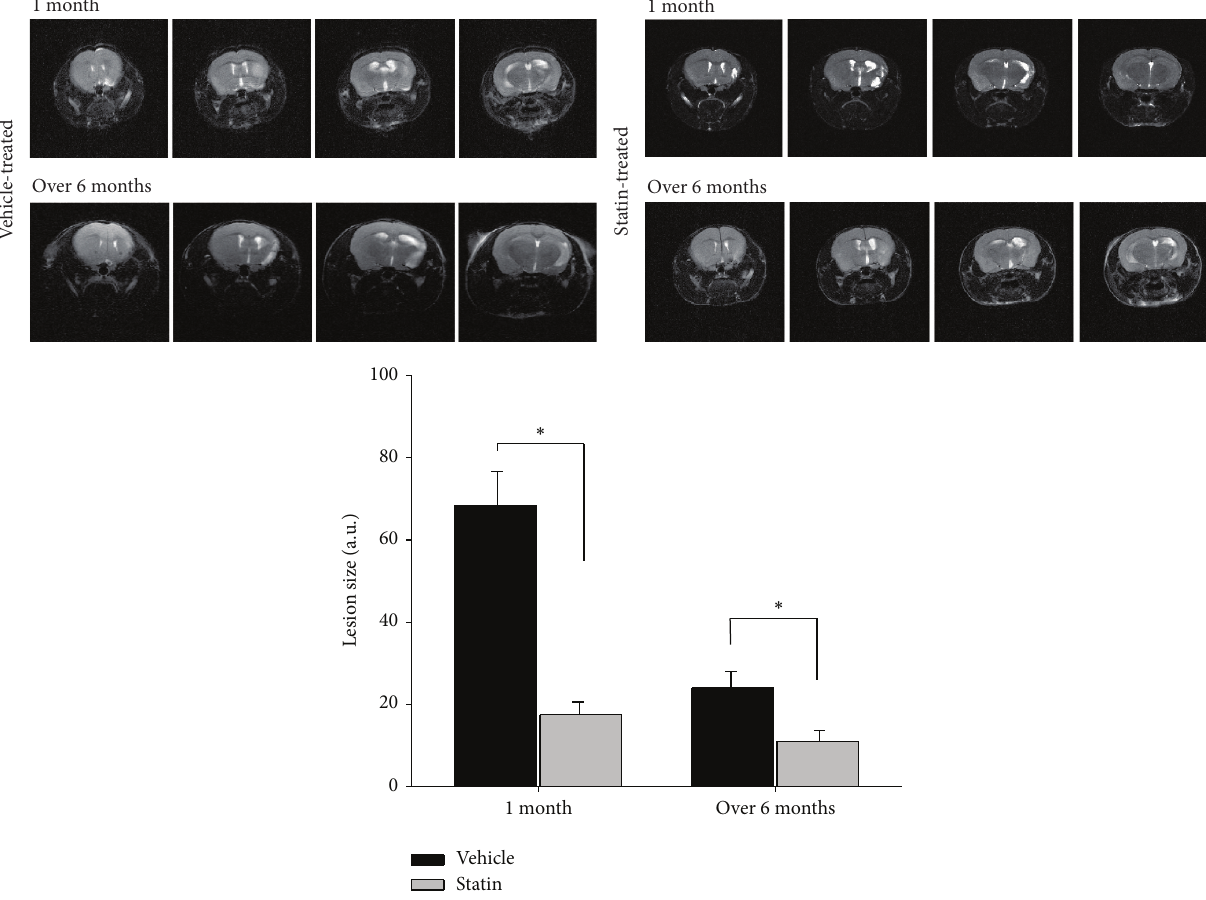
Figure 3: Ischemic brain damage and convalescent processes shown by magnetic resonance imaging (MRI) after